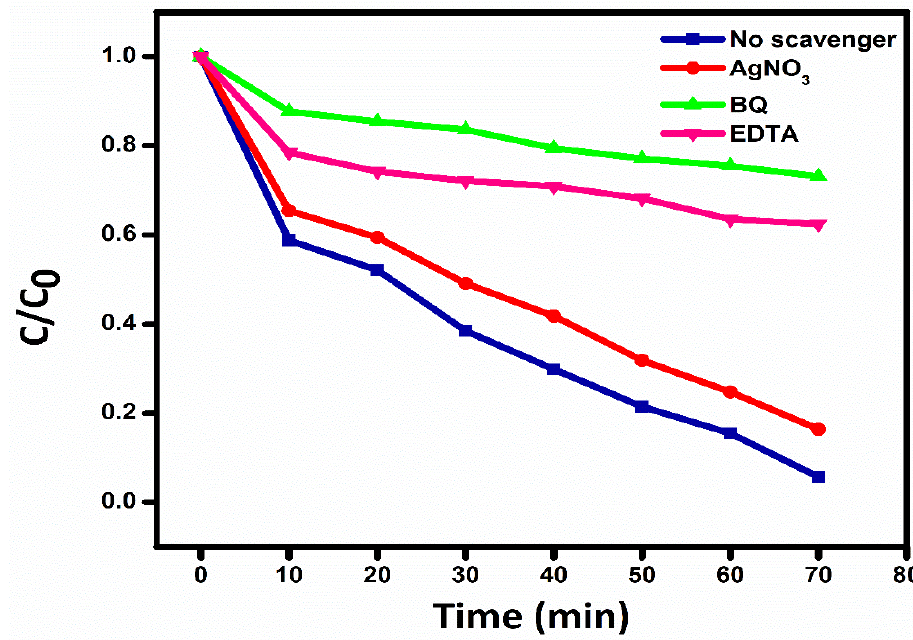
Crystals 2023 , 13 , x FOR PEER REVIEW 13 of 17 Figure 9. The photodegradation of RhB using different scavengers on ZnO/C 3 N 4 under sunlight.